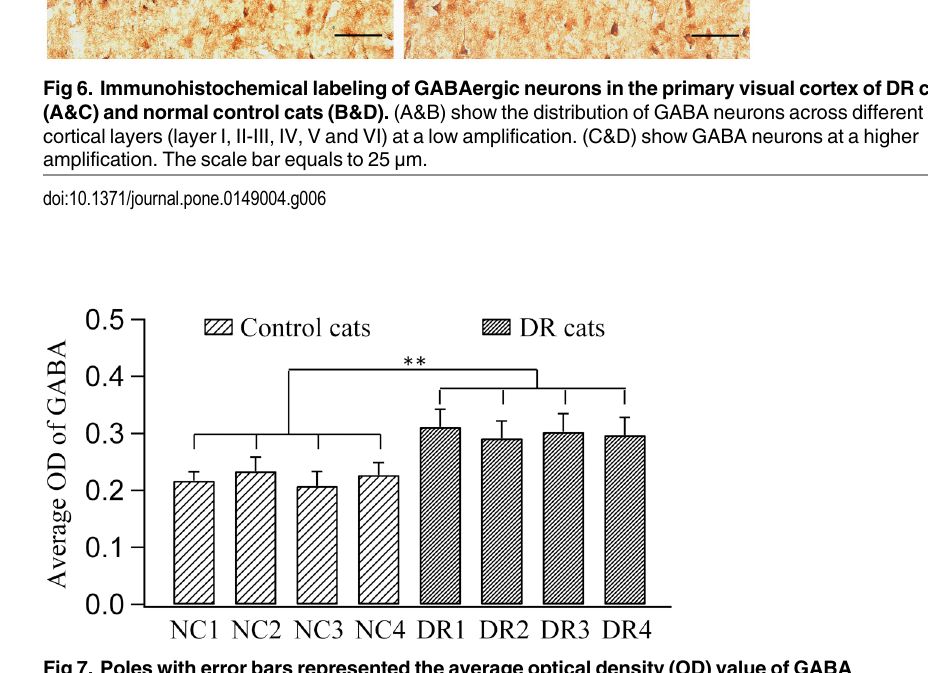
Fig 7. Poles with error bars represented the average optical density (OD) value of GABA immunoreactivity in the primary visual cortex of each normal control cat (NC1-4) and DR cat (DR1-4). The mean OD of GABA immunoreaction in each DR cat was significantly larger than that in any individual control cat ( ** p < 0.001).